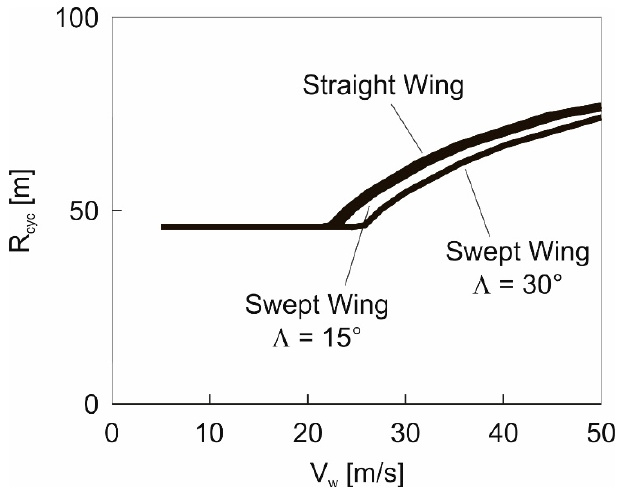
Figure 19. Effect of wing sweep on the trajectory radius for swept wing configuration 1 in maximum-speed dynamic soaring.